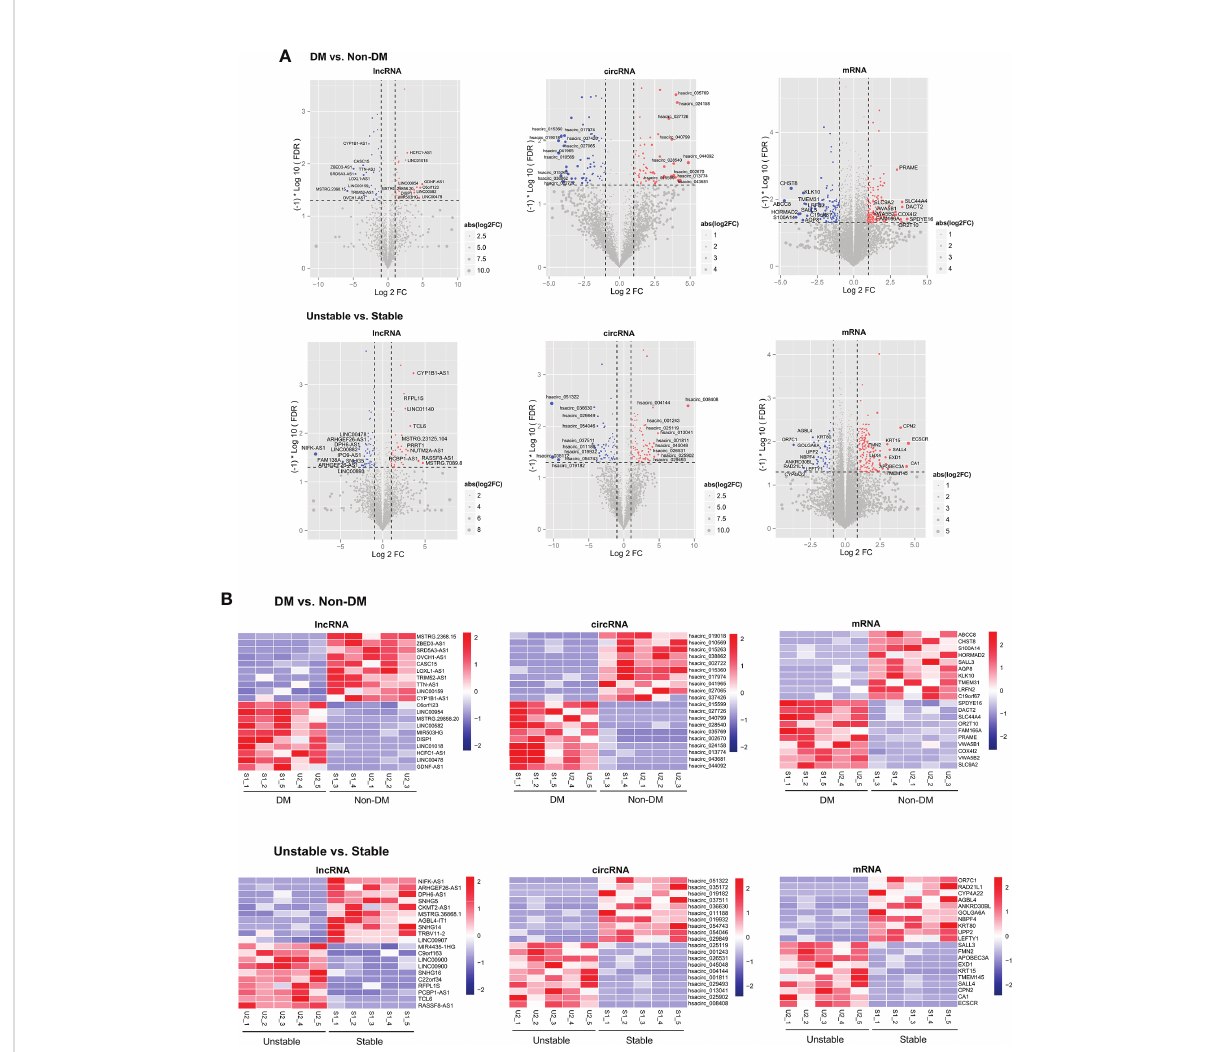
FIGURE 2 (A) The DM versus non-DM and unstable versus stable comparison groups volcano plot. The blue and red dots respectively indicated signi fi cantly downregulated and upregulated RNAs, the horizontal dotted line indicated FDR<0.05, and the two red vertical dotted lines indicated |log2FC|>0.5. The top 10 RNAs are marked. (B) Heat map of the expression levels of the top 10 RNAs in DM versus non-DM and unstable versus stable